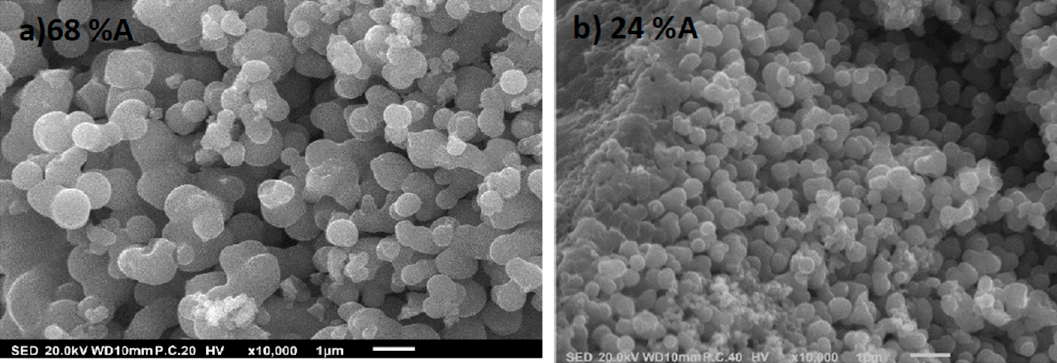
Figure 8. SEM images for annealing times of ( a ) 60 min and ( b ) 180 min.